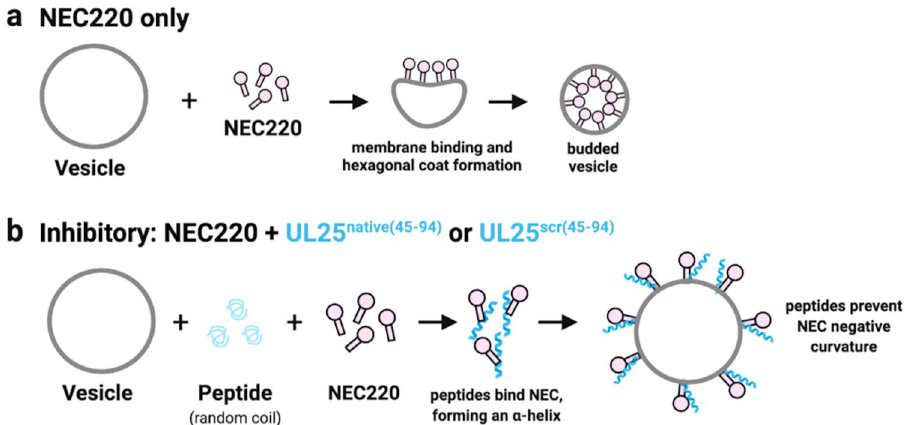
Figure 6. Proposed model of peptide inhibition of the NEC-mediated budding. ( a ) NEC (pink) alone binds membranes, induces negative membrane curvature, and generates a budded vesicle containing an internal hexagonal NEC coat. ( b ) Both UL25 native(45–94) and UL25 scr(45–94) (bluegreen) inhibit budding by forming α-helices upon binding to the NEC, which likely prevents conformational changes necessary for the formation of the negative membrane curvature. This figure was generated using Biorender (https ://biore